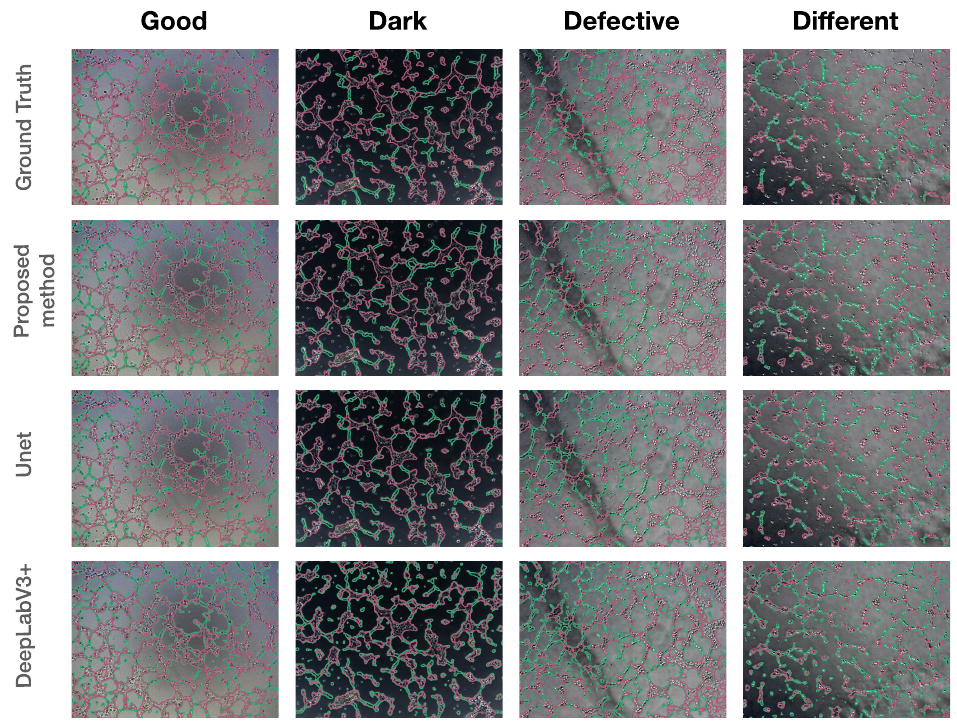
Figure 5. Results of qualitative segmentation by the proposed method, Unet, and DeepLabV3+ ( × 100